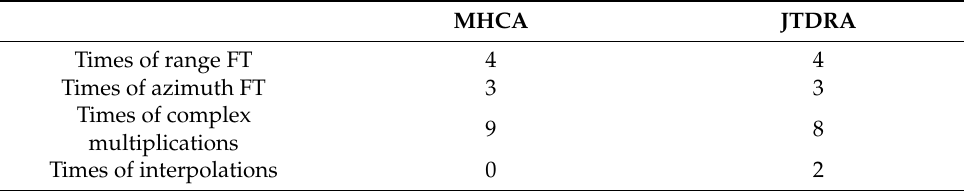
Table 5. Analysis of the computational complexity for different